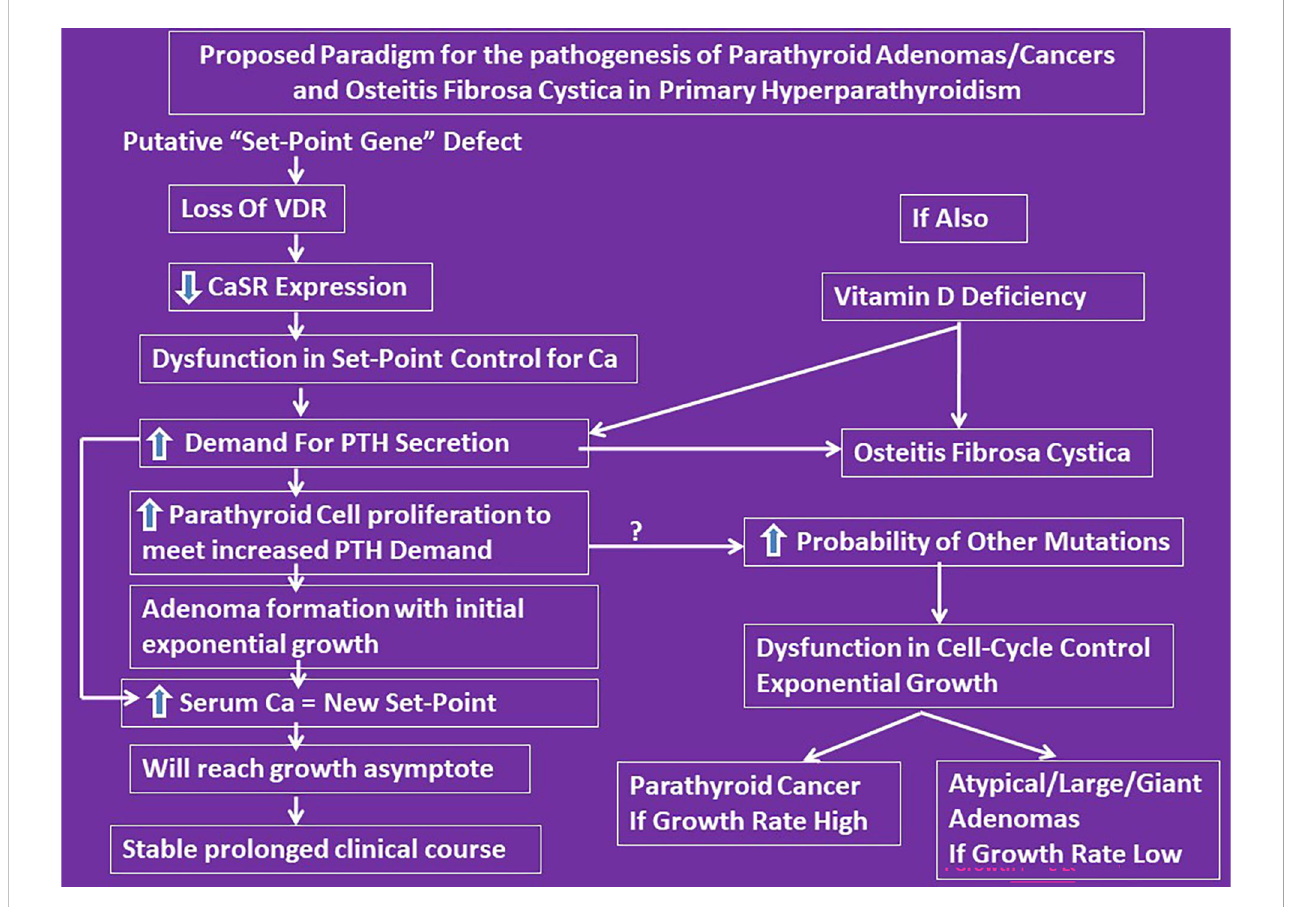
FIGURE 4 Proposed conceptual mechanistic explanation for the pathogenesis of both large adenomas and osteitis fi brosa cystica. It reconciles the Lloyd hypothesis of Type-1 and 2 PHPT and the Par fi tt-Rao proposal of set-point and cell-cycle dysfunctions leading to different types of adenoma formation. However, we do yet not know what genes control the set-point. According to this concept, the observed genetic and epigenetic abnormalities are consequences of set-point dysfunction as the initial